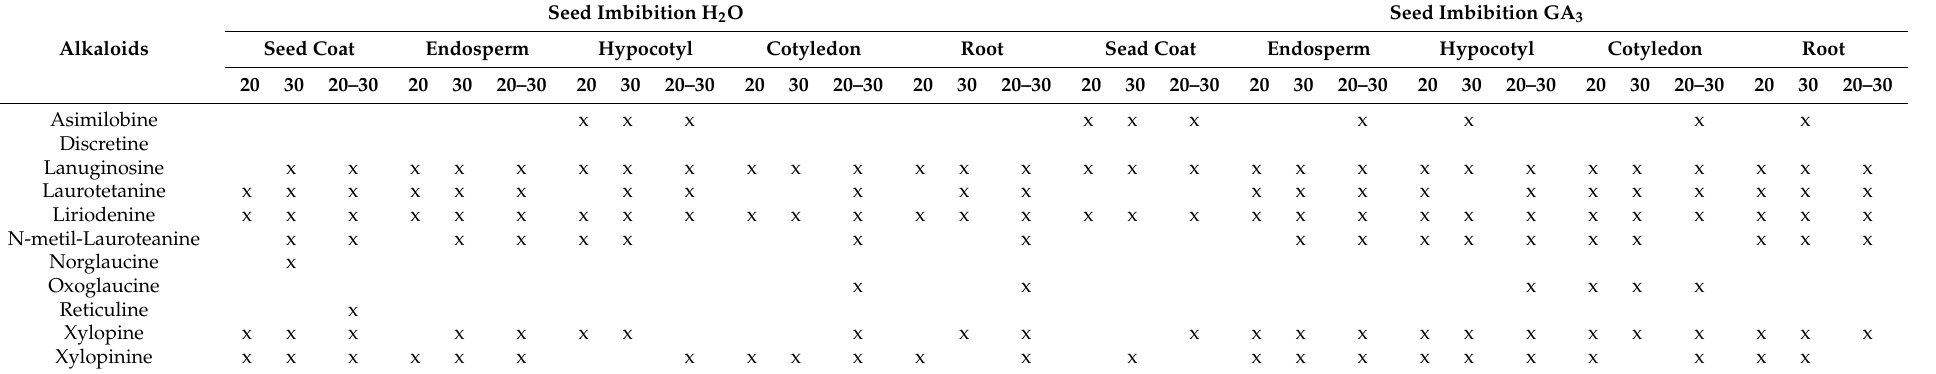
Table 2. Presence (x) or absence ( ) of alkaloids in seedling structures (seed coat, endosperm, root, hypocotyl, and cotyledon) originating from Annona x atemoya Mabb. cv. ‘Gefner’ seeds immersed for 36 h (with H 2 O or GA 3 ) at temperatures of 20 ◦ C, 30 ◦ C, and 20–30 ◦ C and kept at the same temperatures during early development. Seed Imbibition H 2 O